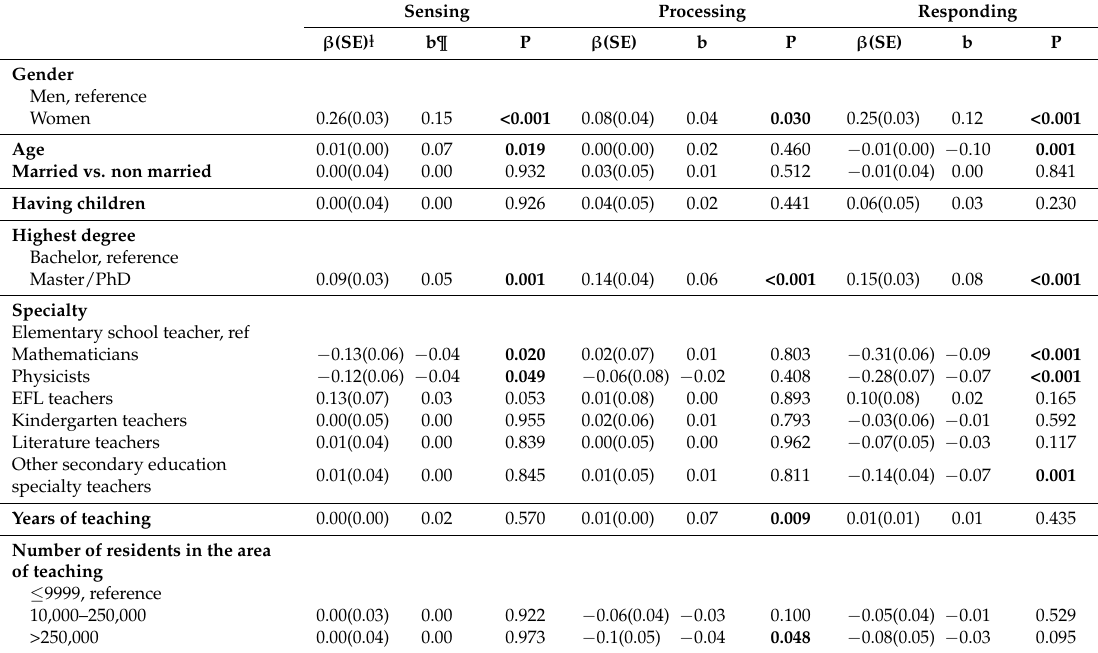
ⱡ Regressions coefficients (standard errors); ¶ standardized regression